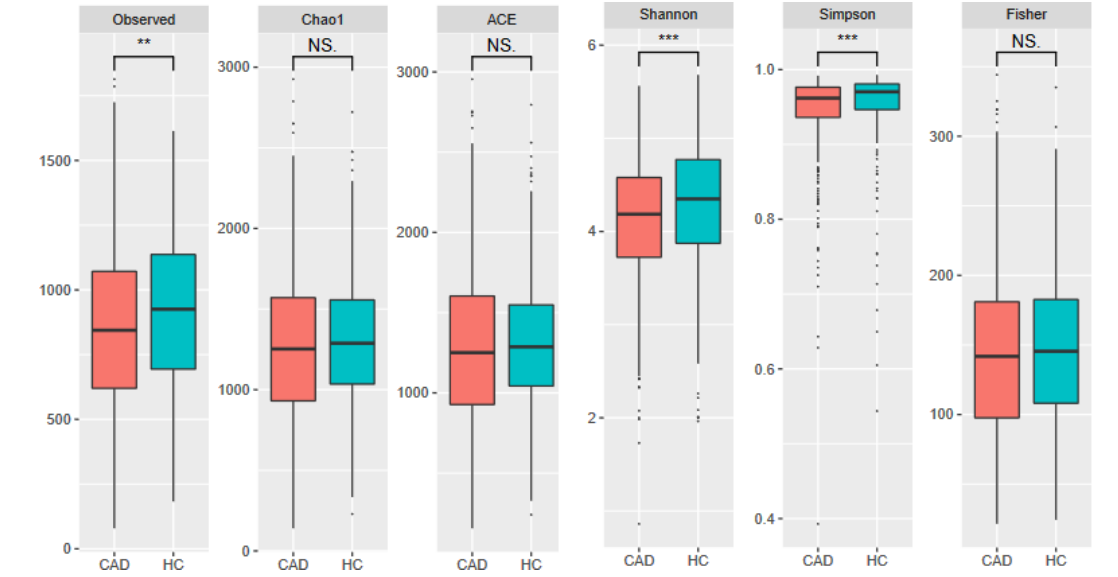
Figure 4. Alpha-diversity results for combined dataset. Asterixis describe statistically significant results: **- p ≤ 0.01, ***- p ≤ 0.001, ns-non-significant; dots denote outlier values.